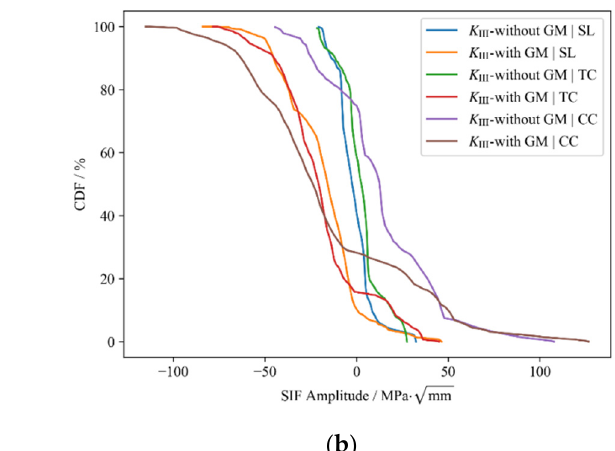
marks; ( e ) SIF of type III cracks without the grinding marks; ( f ) SIF of type III cracks with the grinding marks.